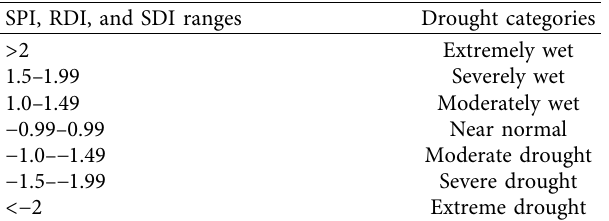
Table 3: Hydrometeorological drought category based on SPI, RDI, and SDI values